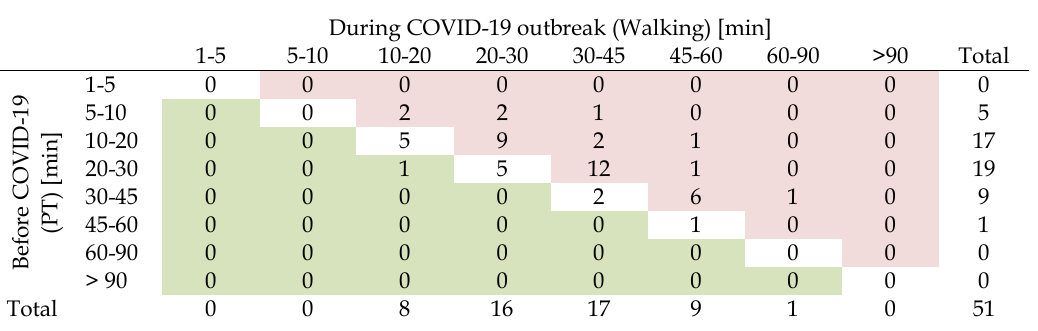
Table 8. Cross-table of one-way commuting duration before and during COVID-19: public transport to walking